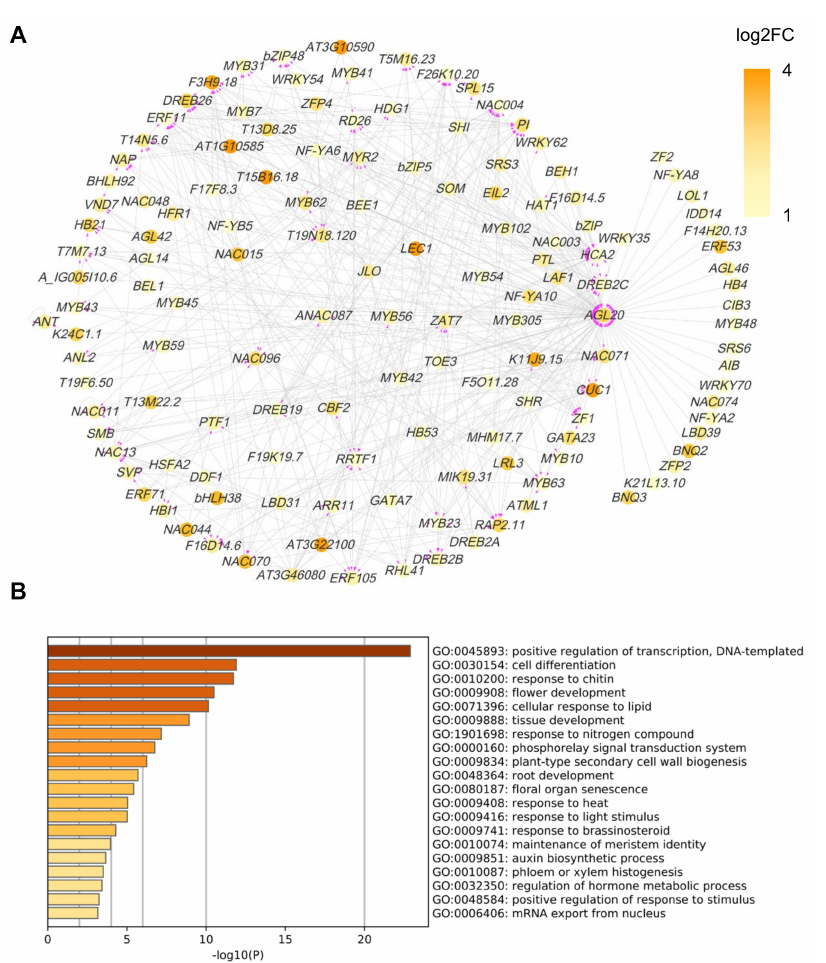
Figure 9. Analysis of the transcription factor (TF) network of the DEGs in the roots of coe2 . ( A ) The TFs of DEGs of cotyledons of coe2 were selected to build the TFs regulatory network. The color key indicates low to high gene expression levels (log2 FC). ( B ) GO analysis of the TFs shown in ( A